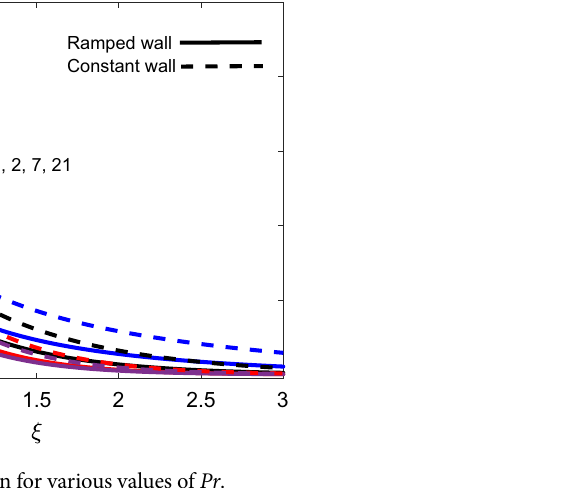
Figure 13. Velocity distribution for various values of Pr